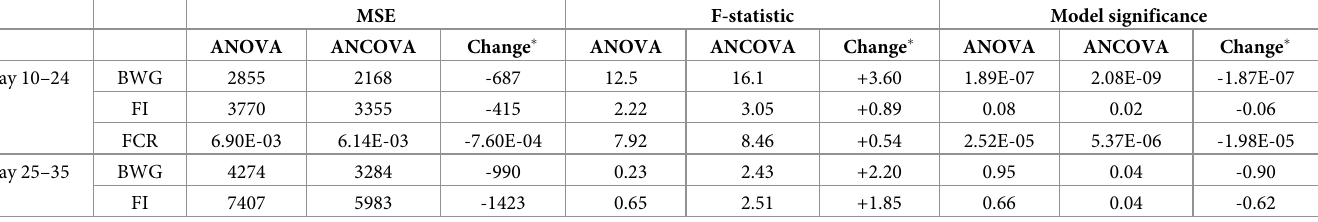
Table 2. MSE, F-statistic and model significance of performance data when analysed by a one-way ANOVA and ANCOVA during different phases for Experiment 1. MSE